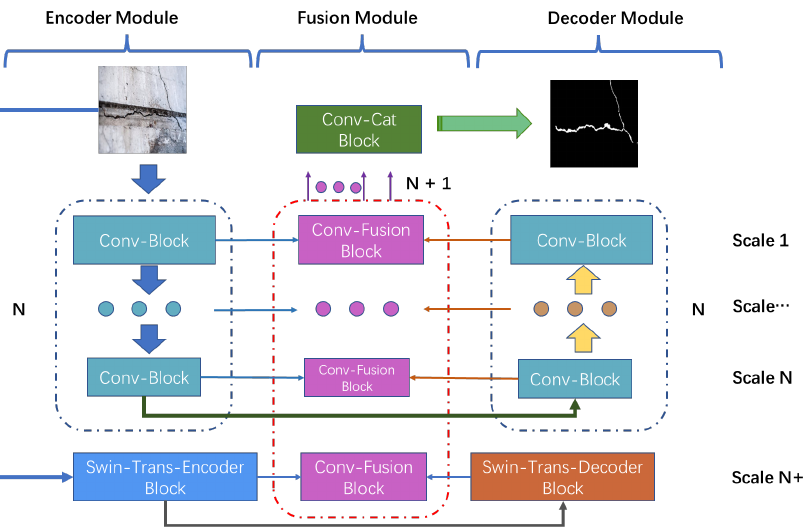
Figure 1. The overall framework of the proposed TransMF, which consists of three modules: an Encoder Module (EM), Decoder Module (DM) and Fusion Module (FM). Both the Encoder Module (EM) and Decoder Module (DM) utilize a hybrid of Convolutional Neural Networks (CNNs) and Swin Transformers, which are symmetrical. The Fusion Module (FM) fuses multi-scale features to form a comprehensive